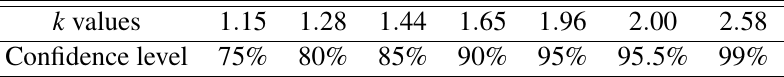
Table 3 k − values for different confidence levels.